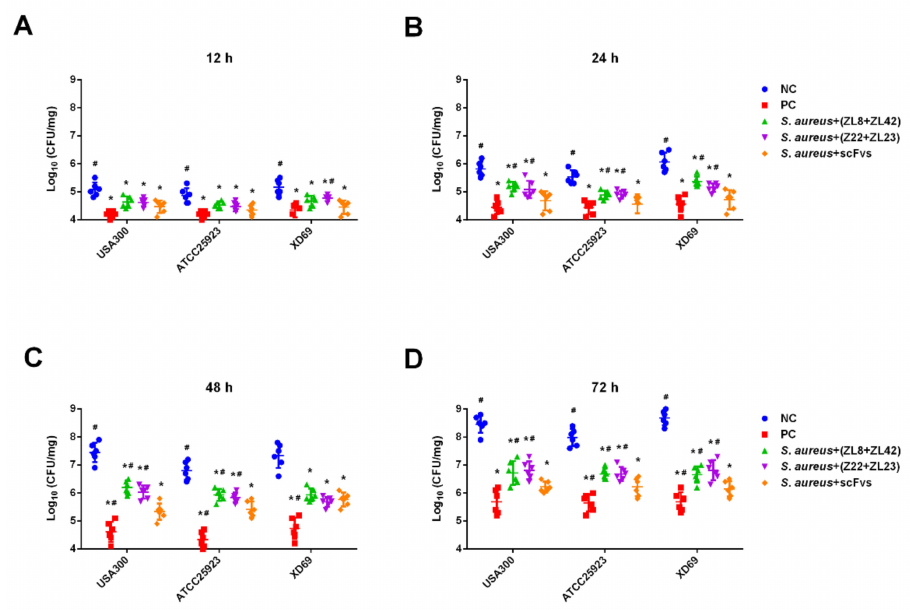
Figure 6. Bacteria proliferation assay. ( A – D ) The proliferation of the three strains were inhibited by the scFvs mixture in mammary gland tissues over time. Data represent the mean results ± SD ( n = 6). # p < 0.05 vs. the scFvs mixture group. * p < 0.05 vs. the NC group.